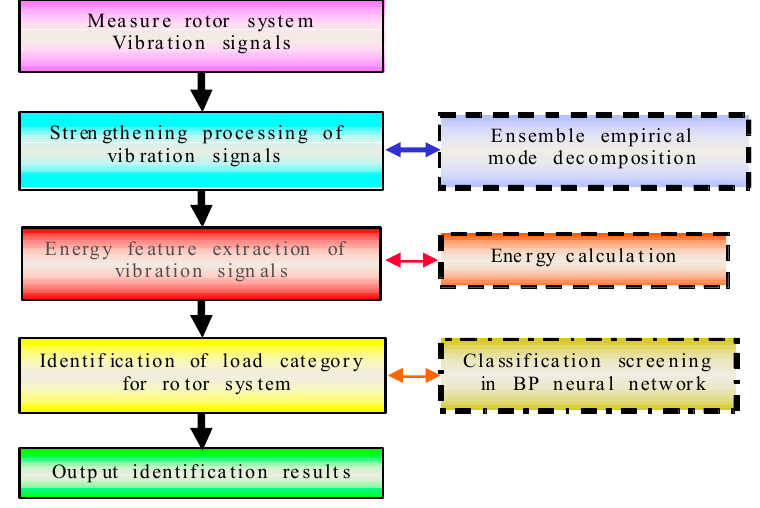
Figure 1. Flowchart of identification method of load categories for rotor system.